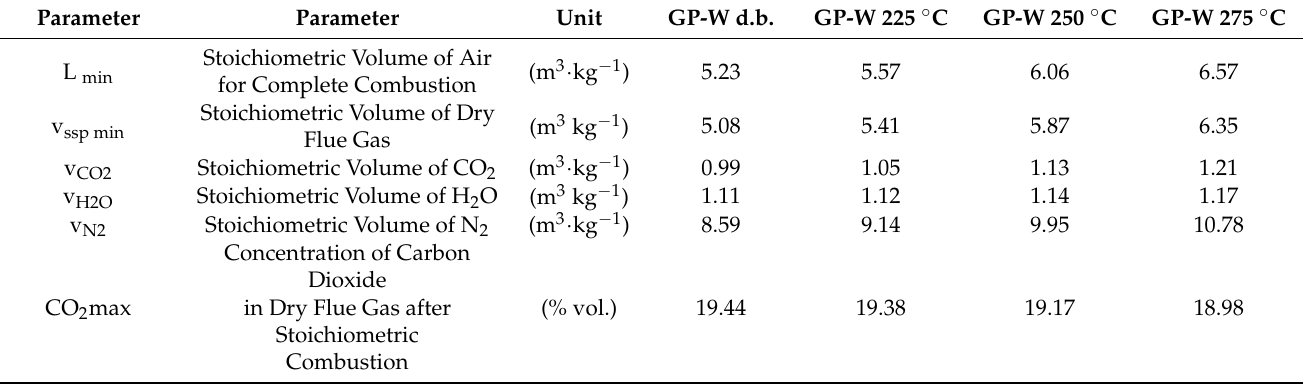
Table 3. Stoichiometric amount of air and specific productions of flue gas components from combustion grape pomace from white grapevine (GP-W); d.b., dry basis.